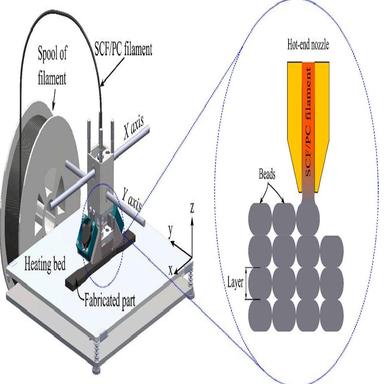
The process description of the FFF technology.